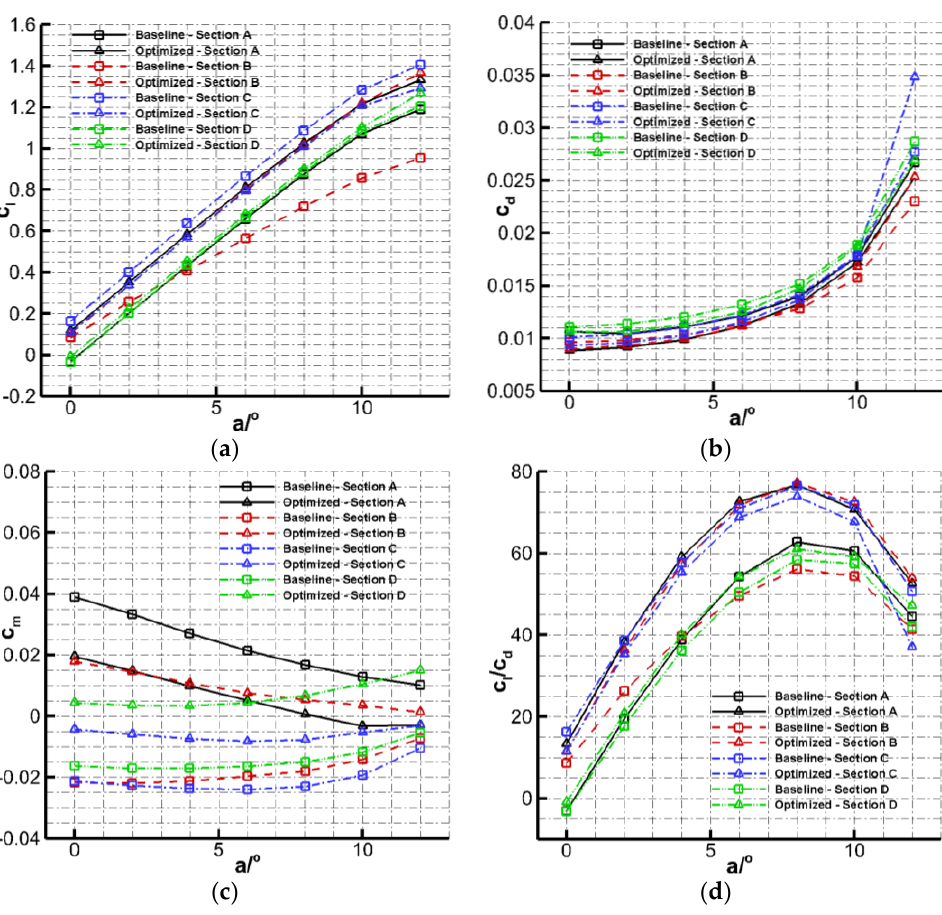
Figure 11. Comparison of the sectional airfoil performance between before and after the optimization. ( a ) Lift performance. ( b ) Drag performance. ( c ) Pitching performance. ( d ) Lift-to-drag performance.